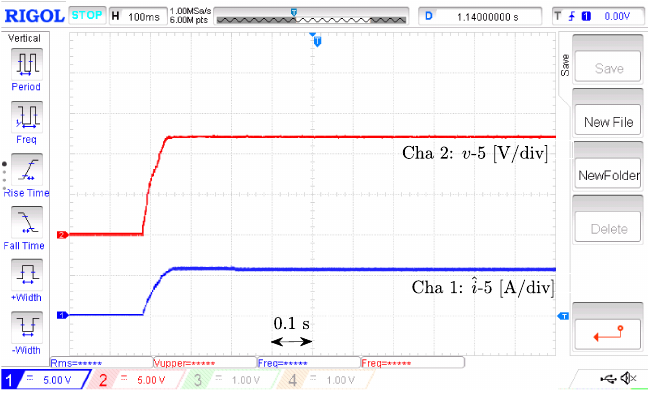
Figure 8. The transient of boost converter under the proposed controller.